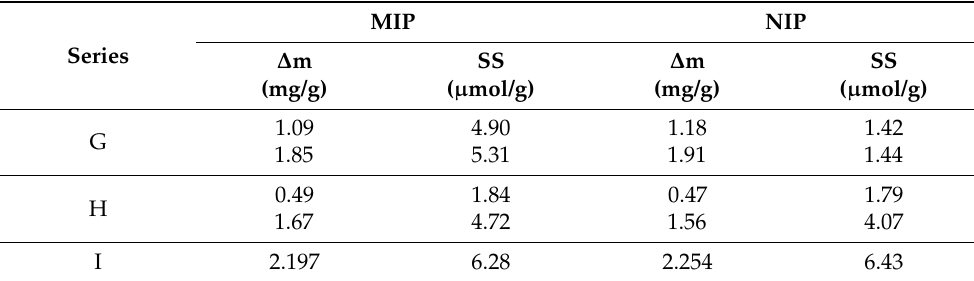
Table 3. Sorptive properties of membranes modified from solutions with different